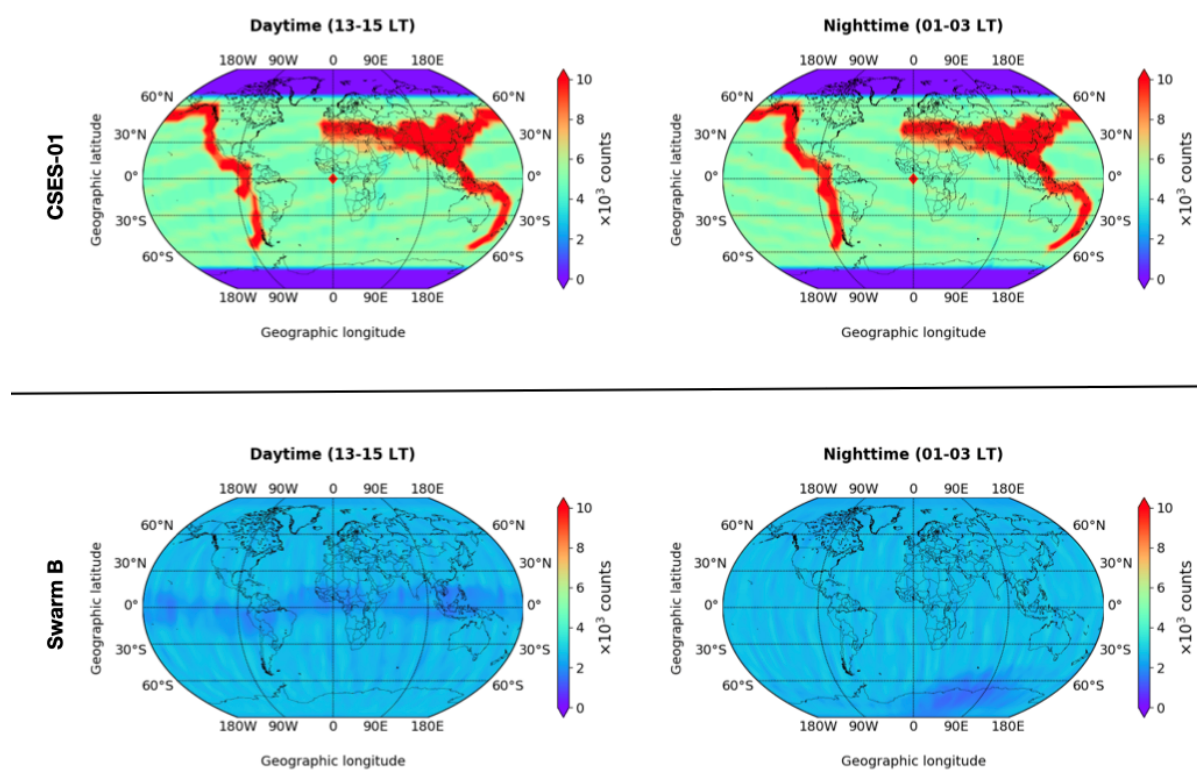
Figure 4. Number of counts (in units of 10 3 ) falling within each bin for both CSES-01 ( top row ) and Swarm B ( bottom row ) missions in the daytime ( left column ) and in the nighttime ( right column